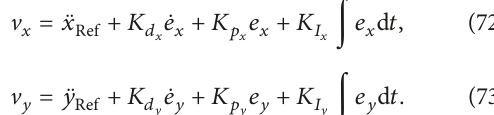
Figure 3: System disturbances for the simulation.